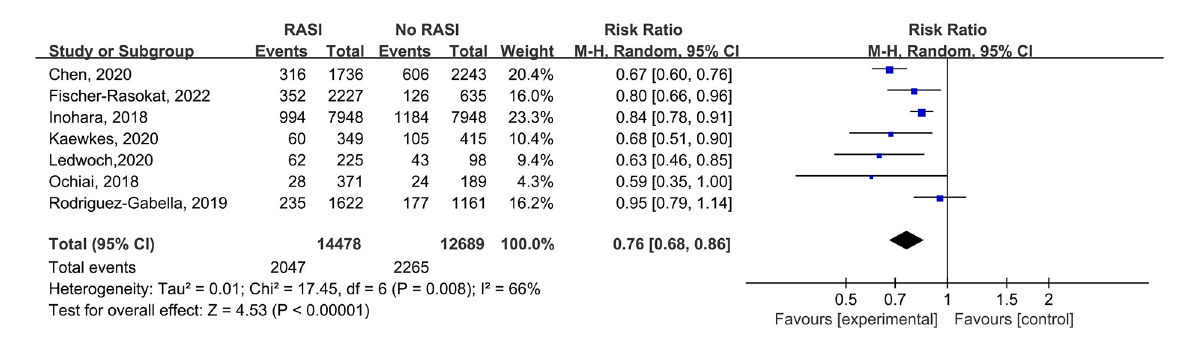
included studies found that age, sex and baseline LVEF did not have any modulating effect on all-cause mortality for